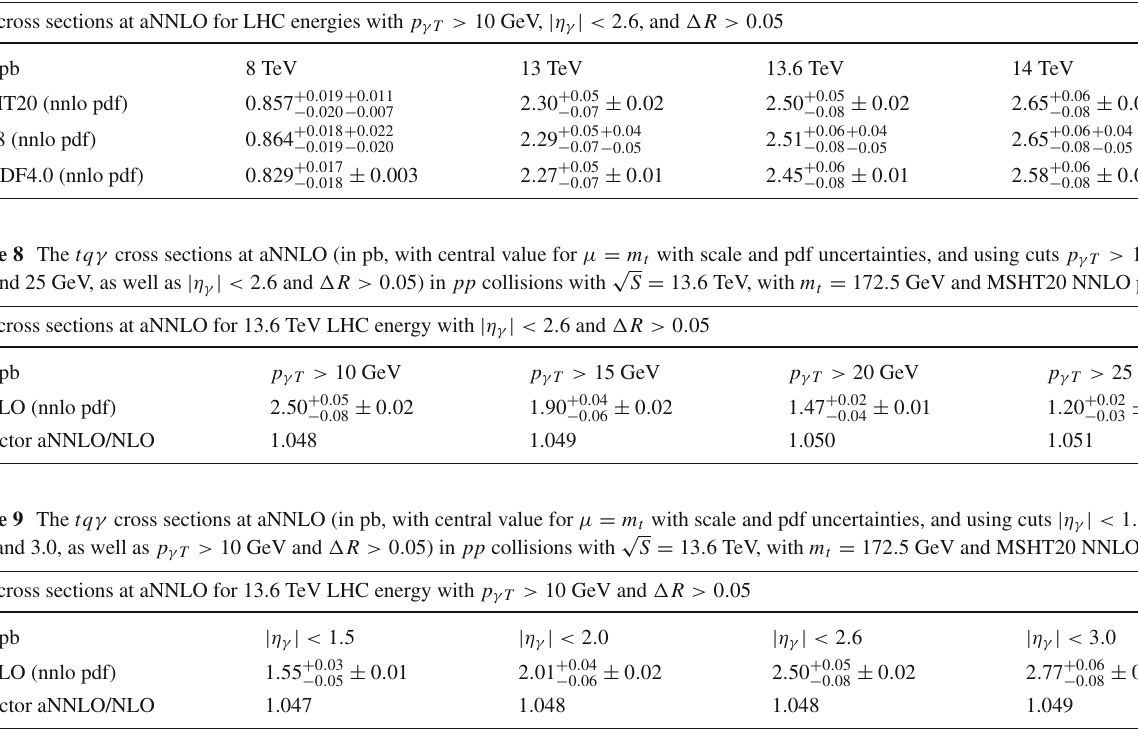
Table 7 The tq γ cross sections at aNNLO (in pb, with central value for μ = m t with scale and pdf uncertainties, and using cuts p γ T > 10 GeV, √ | η γ | < 2 . 6, (cid:7) R > 0 . 05) in pp collisions with S = 8, 13, 13.6, and 14 TeV, with m t = 172 . 5 GeV and various NNLO pdf tq γ cross sections at aNNLO for LHC energies with p γ T > 10 GeV, | η γ | < 2 . 6, and (cid:7) R > 0 . 05